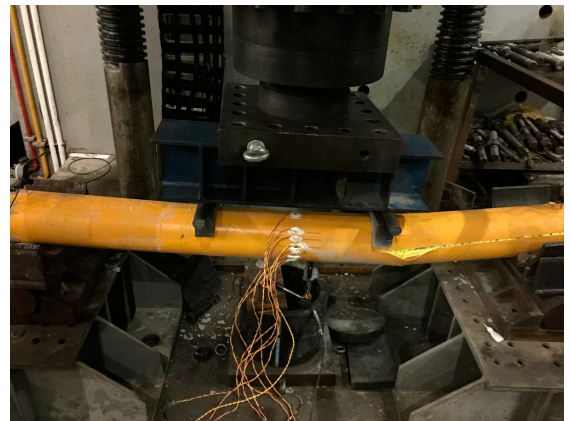
Figure 11. Failure mode of test specimen G-2000-180-8A.